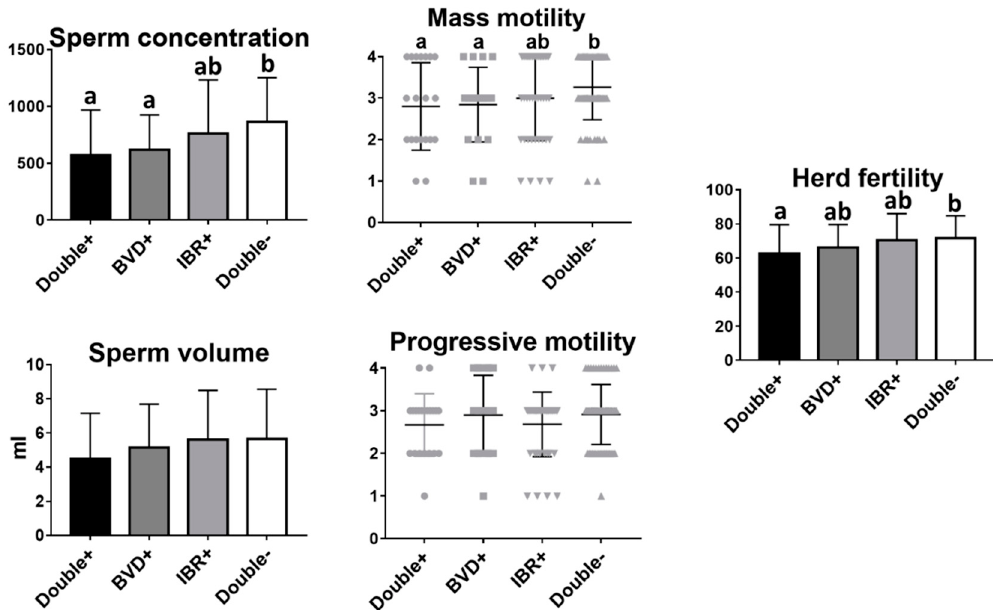
Figure 3. Analysis of sperm parameters and fertility in BVD- and/or IBR-positive and -negative bulls. Mean and SEM of seminal parameters and herd fertility of bulls infected with both BVD and IBR, BVD-only, IBR-only, and negative bulls. Different letters indicate statistically significant differences, One-way ANOVA ( p < 0.05).